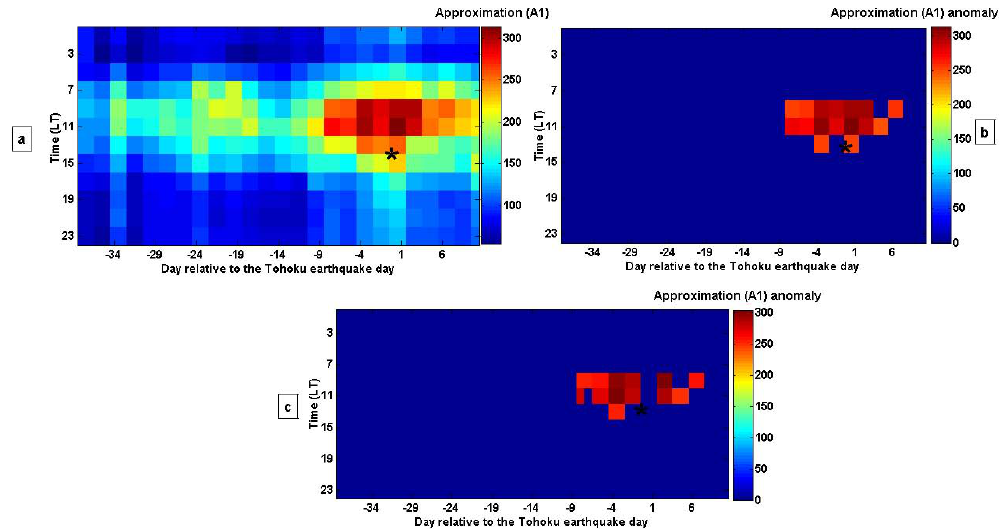
Fig. 4. Results of analysis for the Tohoku earthquake using the approximation coefficients of the wavelet transform method, (a) TEC variations after executing the method, (b) detected TEC anomalies without considering the geomagnetic conditions and (c) detected TEC anomalies during quiet geomagnetic conditions.